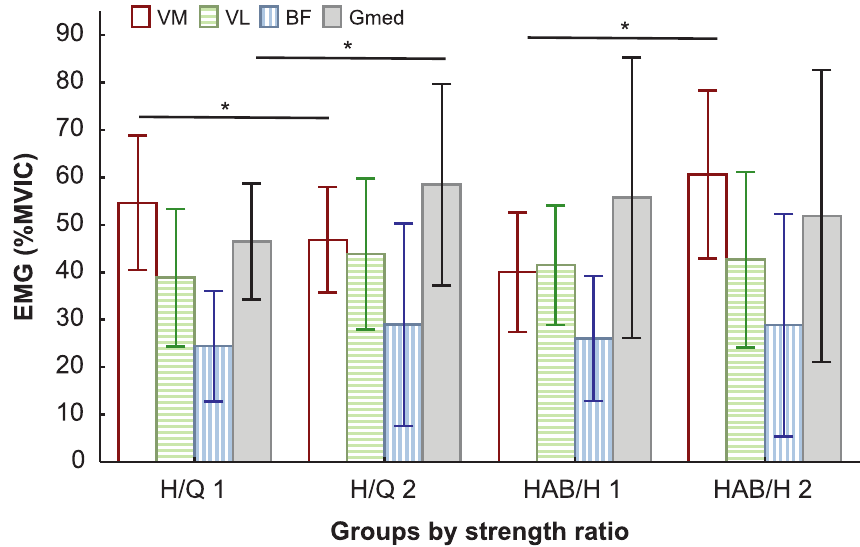
Figure 2. Analysis of variance: differences between groups. VM = vastus medialis, VL = vastus lateralis, BF = biceps femoris, Gmed = gluteus medius, MVIC = maxi- mal voluntary isometric contraction, H/Q 1 = hamstring/quadriceps group 1, H/Q 2 = hamstring/quadriceps group 2, HAB/H 1 = hip abductor/hamstring group 1, HAB/H 2 = hip abductor/hamstring group 2. *significant difference between groups. Rectangular bars represent means, error bars represent standard